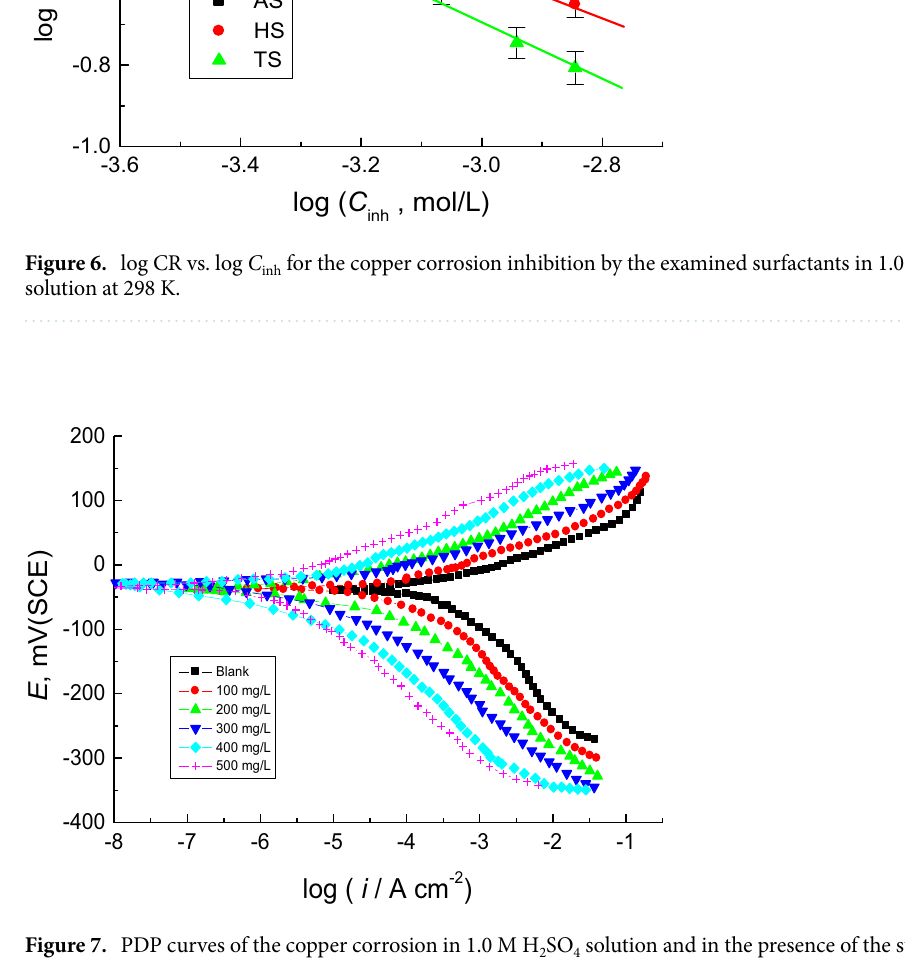
Figure 7. PDP curves of the copper corrosion in 1.0 M H 2 SO 4 solution and in the presence of the surfactant HS at 298